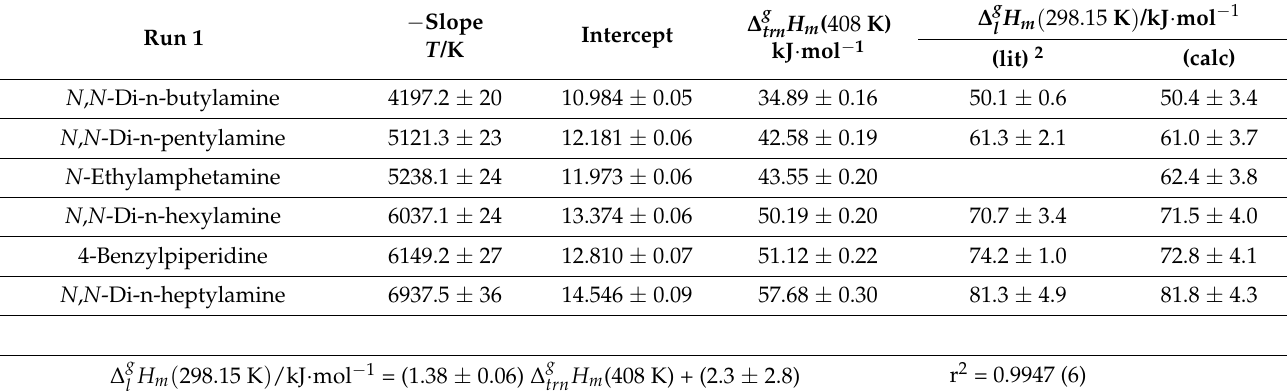
H m ( 298.15 K ) and ∆ g l